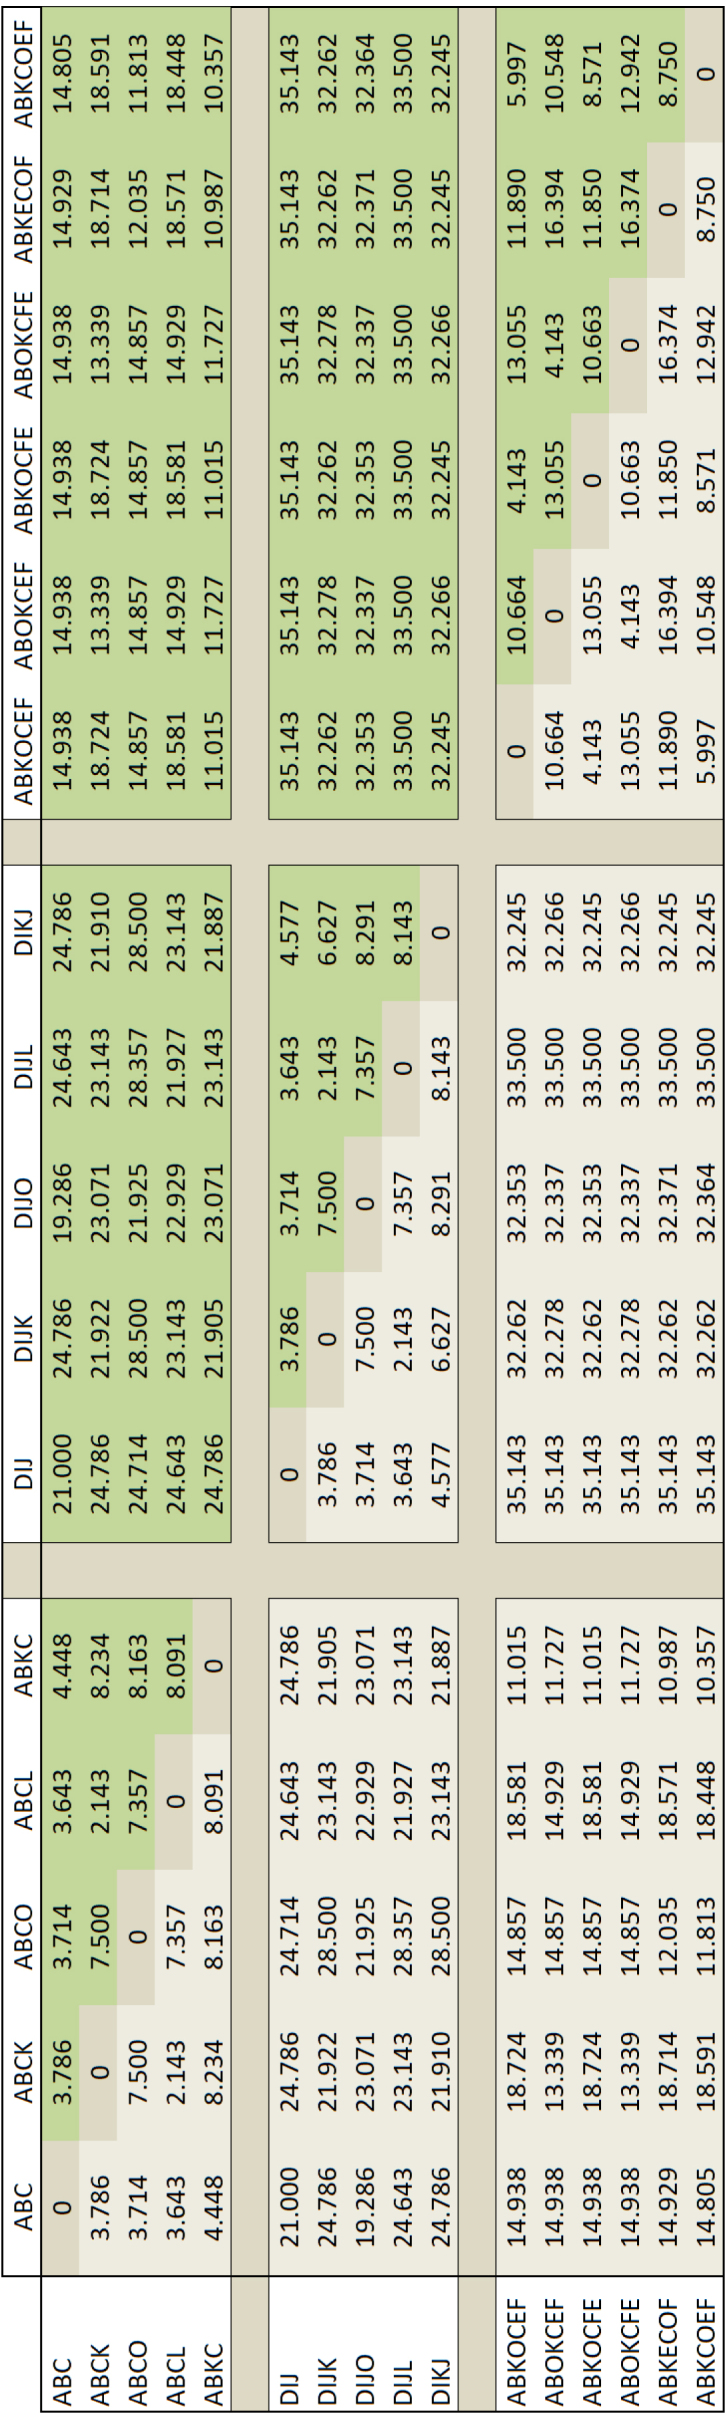
Modified Needleman–Wunsch Distance Matrix for Sample 2.